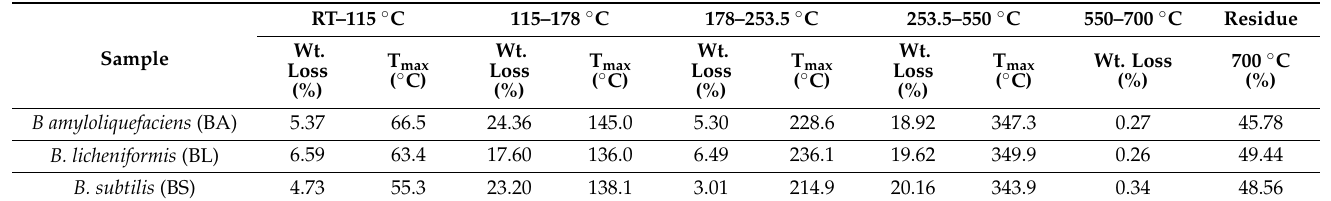
Table 2. Results of TGA analysis applied to deposit samples from bacterial cultivation on medium with urea and Ca 2+ .